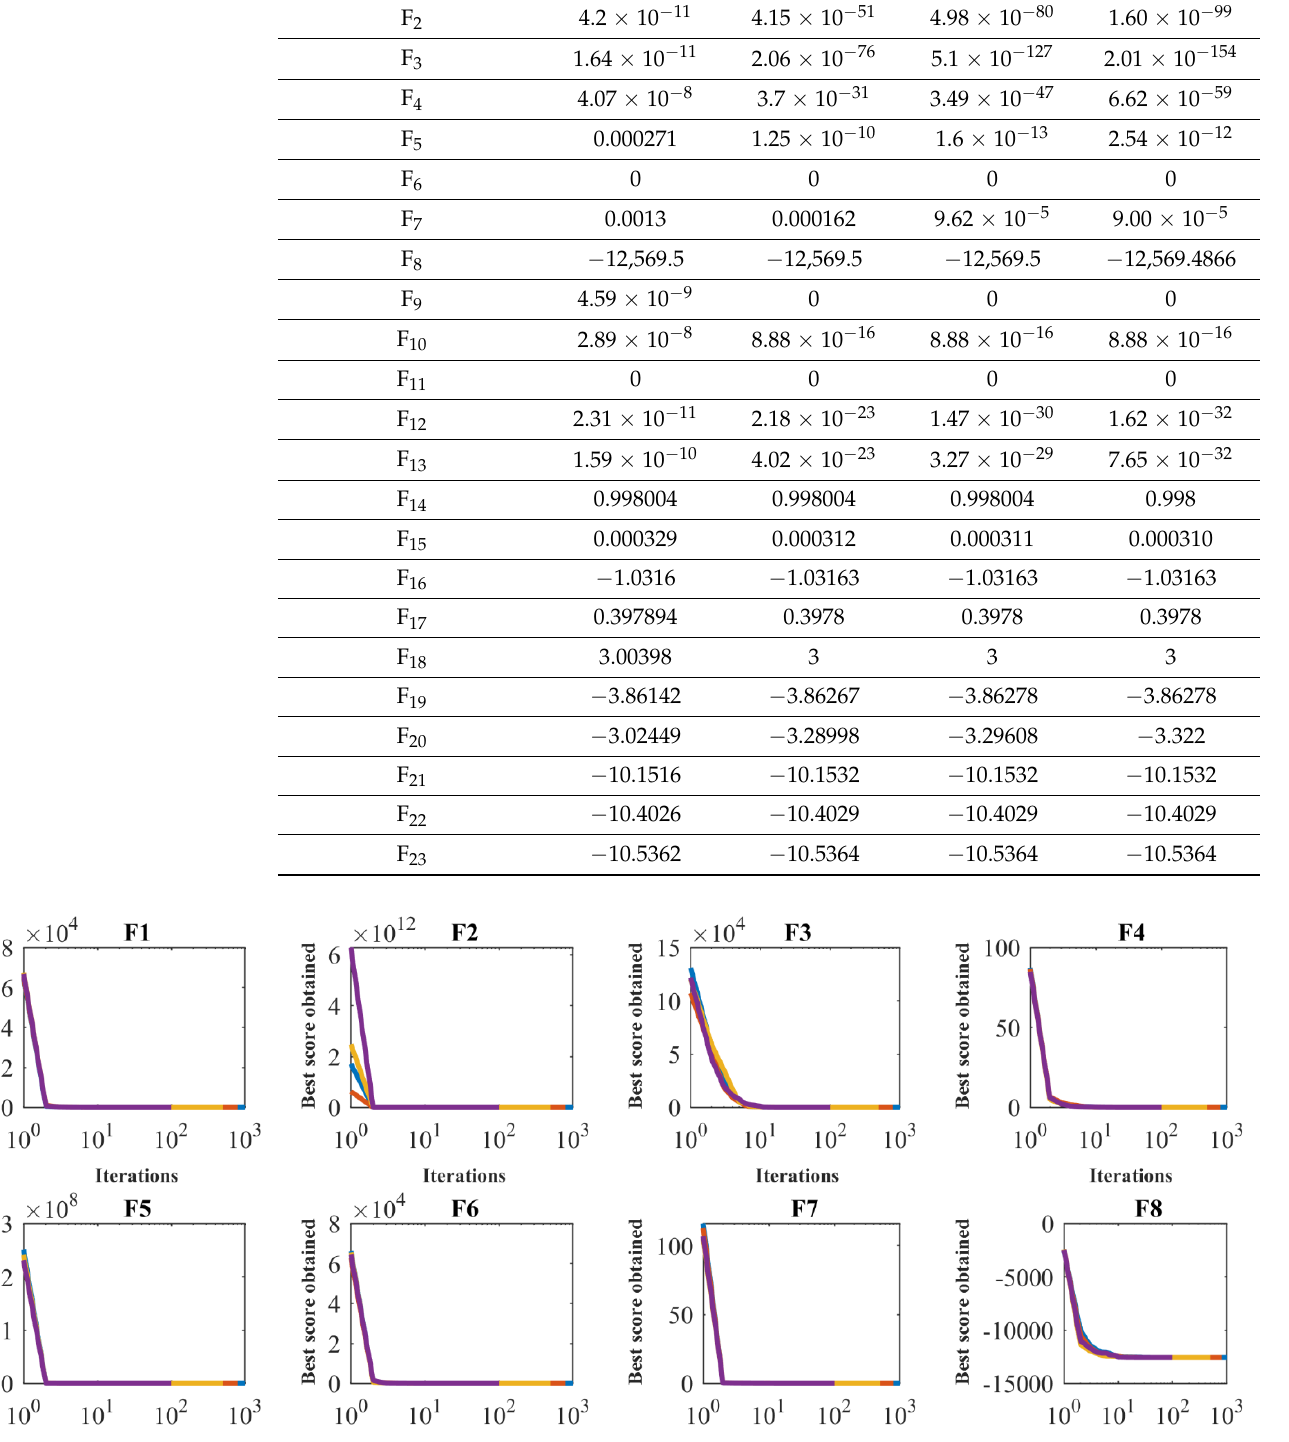
Table 7. Results of sensitivity analysis of SSVUBA to T .